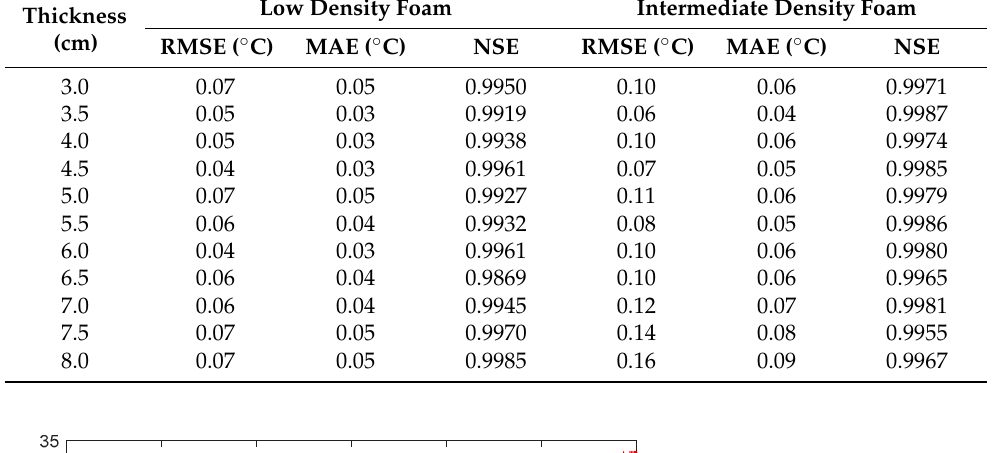
Table 2. Evaluation of the data driven ANN-based estimation.